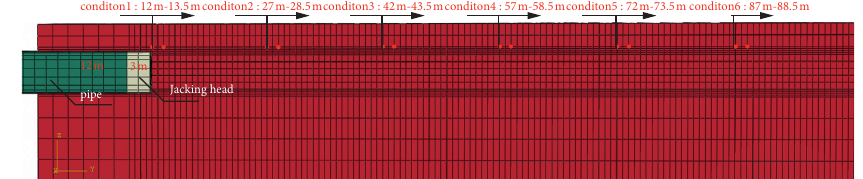
Figure 5: Cross section of the models (model 1: from 12 to 13.5, model 2: from 27 to 28.5, model 3: from 42 to 43.5, model 4: from 57 to 58.5, model 5: from 72 to 73.5, and model 1: from 87 to